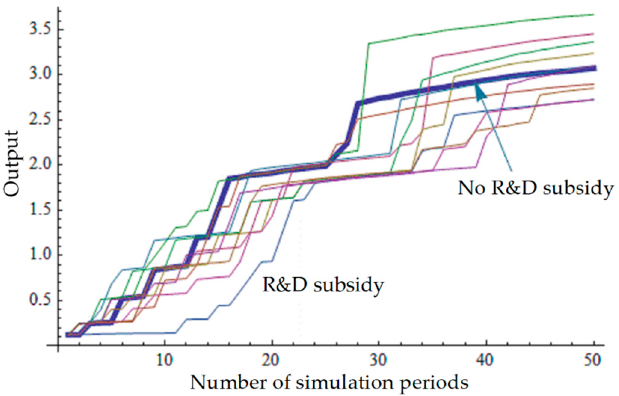
Figure 15. Impact of R&D subsidies for new technology firms on industry output.